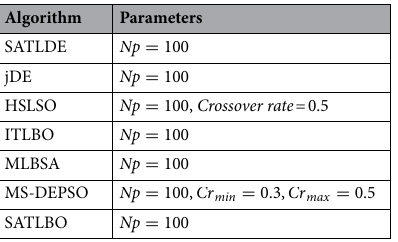
Table 1. Control parameters of all